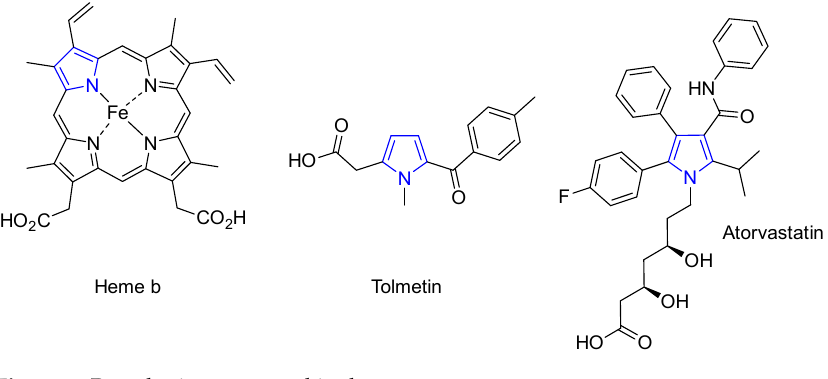
Figure 1. Pyrroles in nature and in drugs.